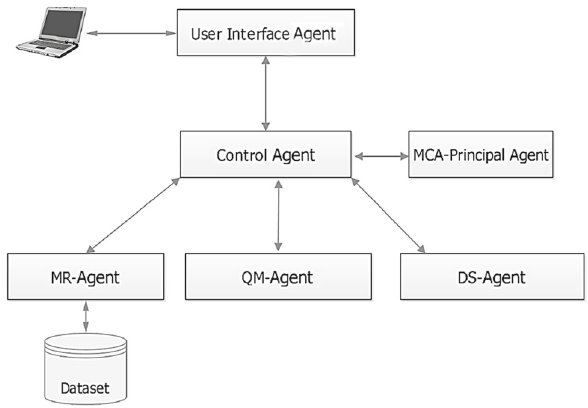
Fig. 5 The architecture of the proposed multi-agent